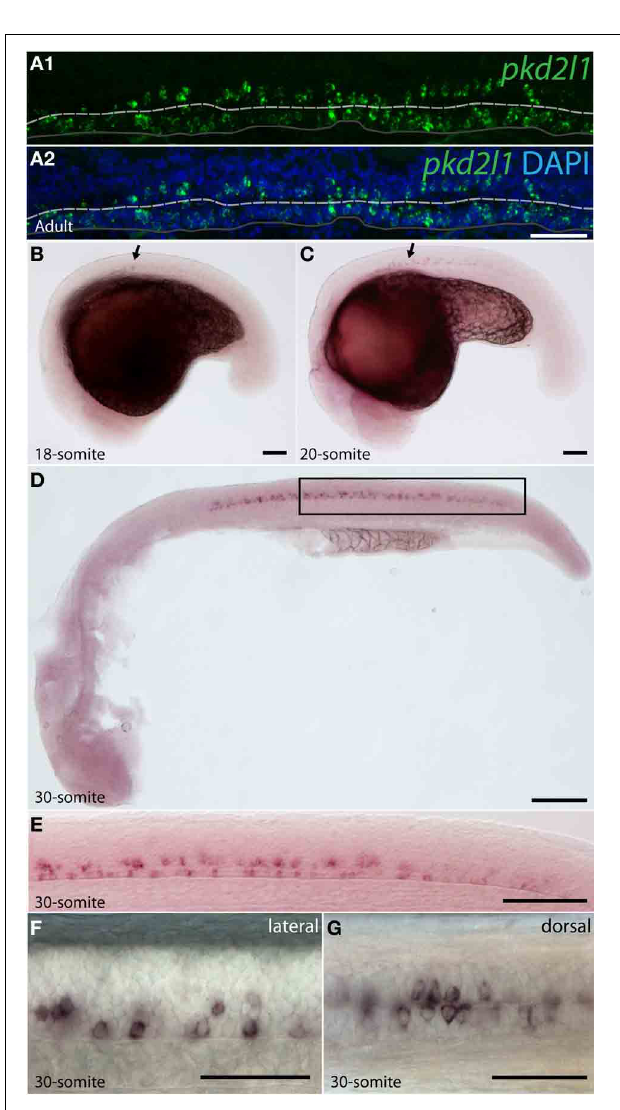
FIGURE 4 | pkd2l1 is expressed from the embryonic 18-somite stage to adulthood in the zebrafish spinal cord. (A) Adult; (B–G) embryonic stages: 18-somite (B) , 20-somite (C) and 30-somite stages (D–G) . (A) In sagittal sections from the adult spinal cord, pkd2l1 + CSF-contacting cells are located ventral and dorsal to the central canal. White dash line: central canal, dark gray line: ventral limit of the spinal cord. pkd2l1 expression appears in the rostral spinal cord ( B,C , arrows) and is distributed in two rows of cells along the rostro-caudal axis (E,F) and on each side of the midline (G) . (E) is a close-up of the black box from (D) . Rostral is to the left for all panels. Lateral views with dorsal up for (A–F) and dorsal view for (G) . DAPI staining appears in blue. Scale bars = 40 μ m (A) , 100 μ m for (B–D) , 50 μ m for (E–G)